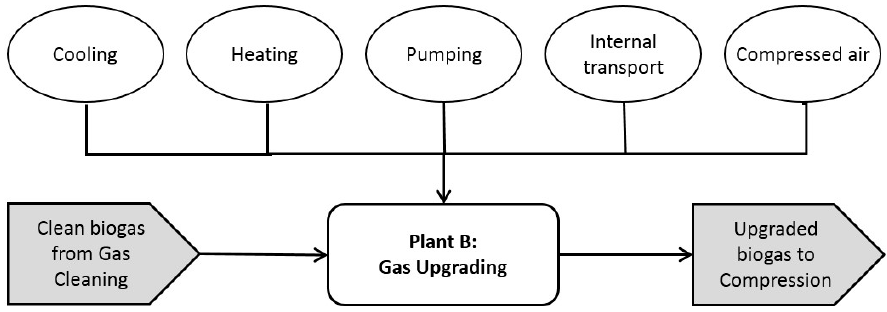
Figure 10. The connection between the sub-process gas upgrading and unit processes at biogas plant B.